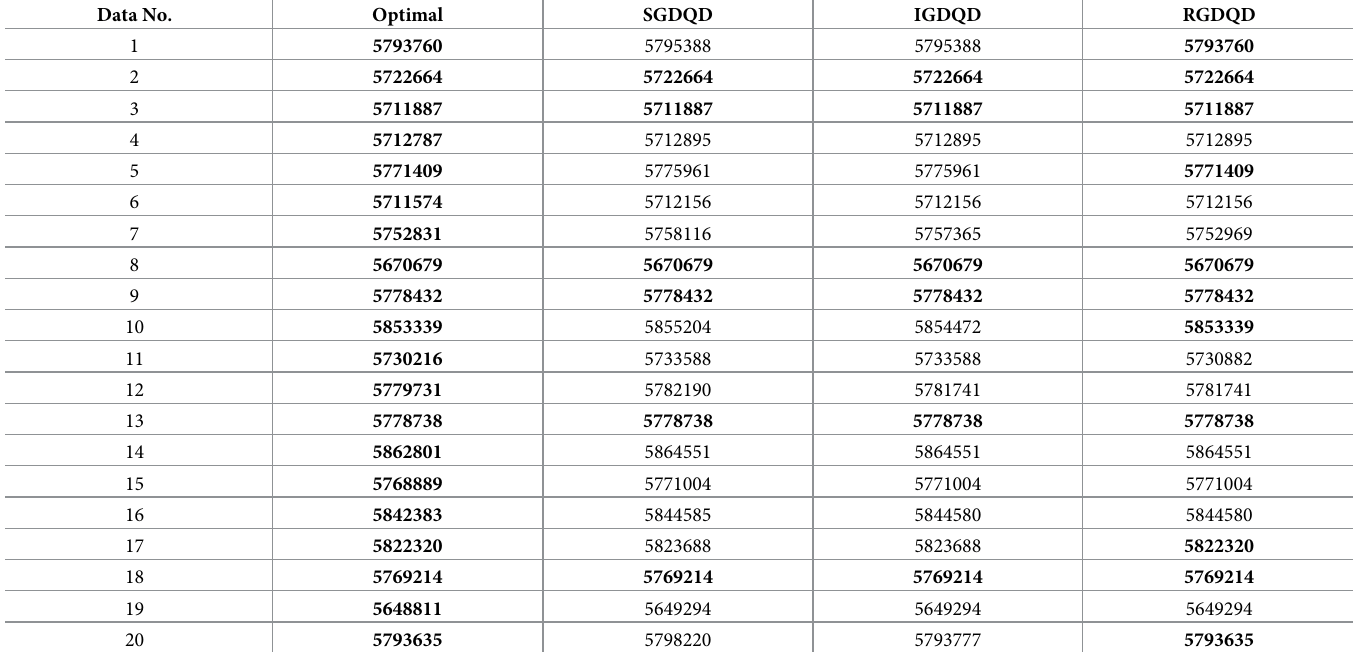
Table 12. Solutions for Q = 600000.